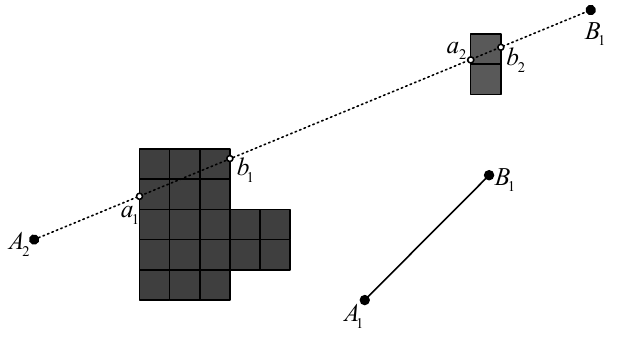
Figure 11. Schematic of a linear path.